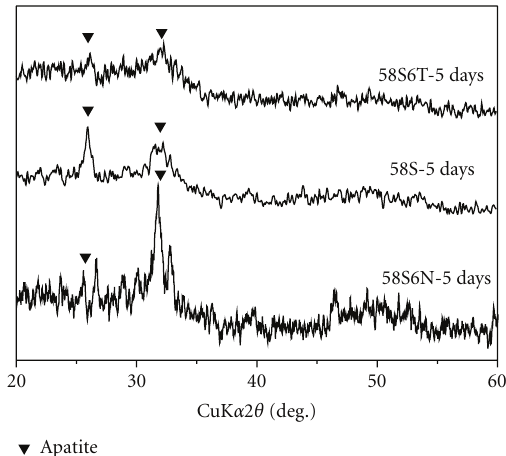
Figure 4: XRD patterns of the 58S, 58S6N, and 58S6T after immersion in SBF for 5 days.